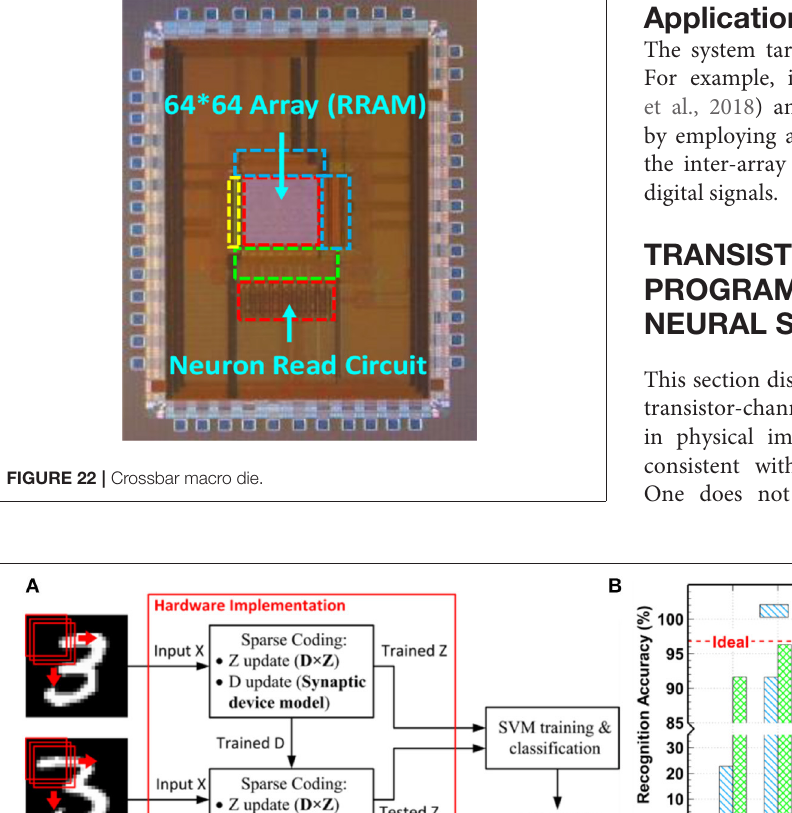
Figure 23A . The MNIST handwritten digits dataset (LeCun et al.,